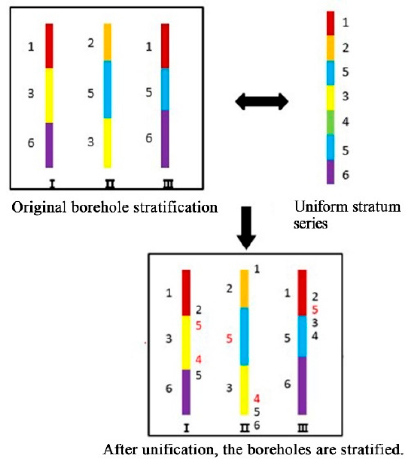
Figure 35. Unified geostratigraphic series diagram.